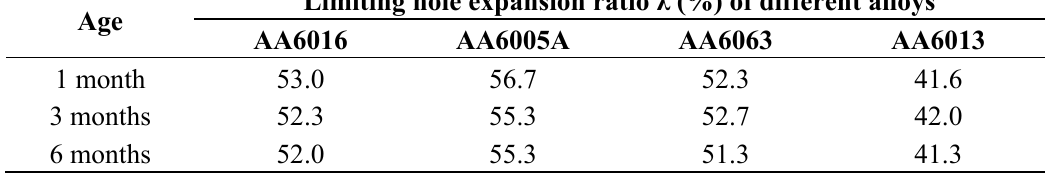
Table 4. Limiting hole-expansion ratio (in %) measured one, three and six months after sheet production in temper